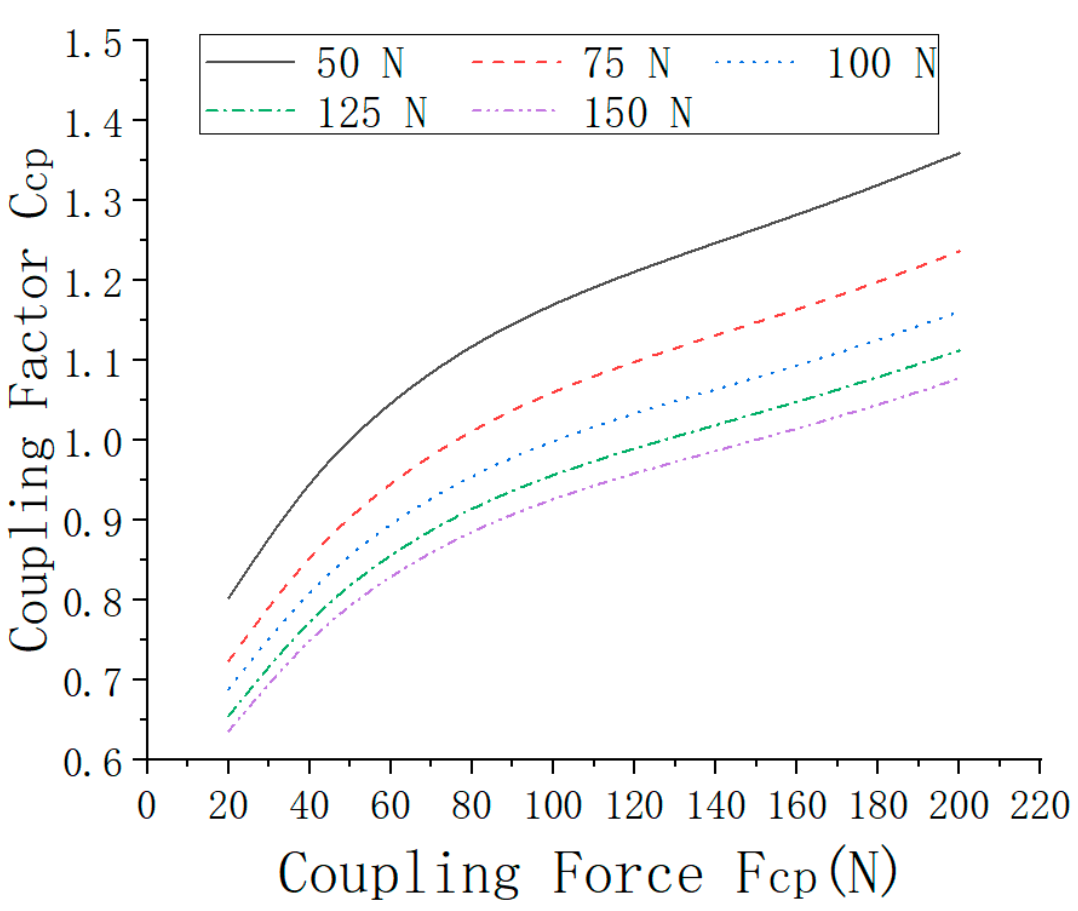
Figure 1. Coupling factor as a function of coupling force for different values of reference coupling forces as given in ISO/TS 15230-2 [11].